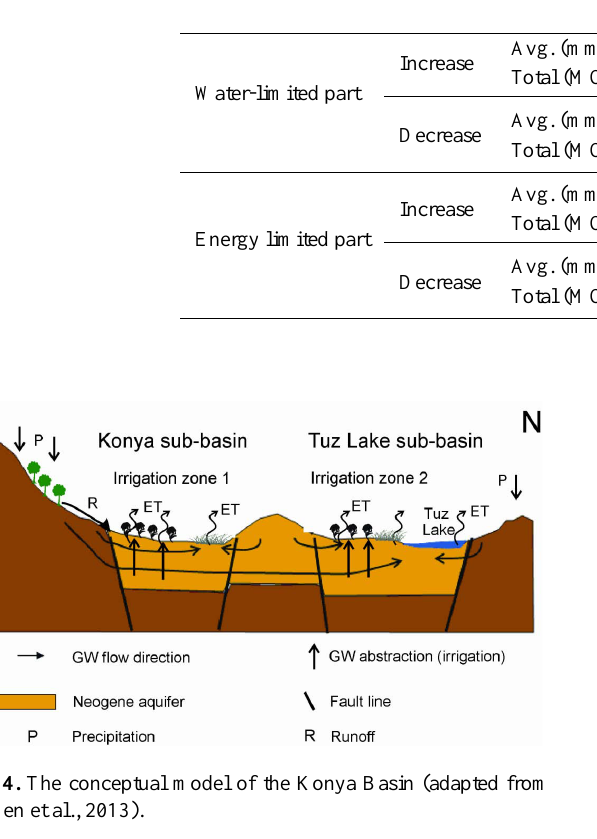
Fig. 15. The histograms of (a) average, (b) total ET changes and (c) average NDVI changes in the areas having significant trend (for p < 0 . 1 significance level), (d) the distribution of the overlaid trends of ET and NDVI in the Konya plain during the study period (2000–